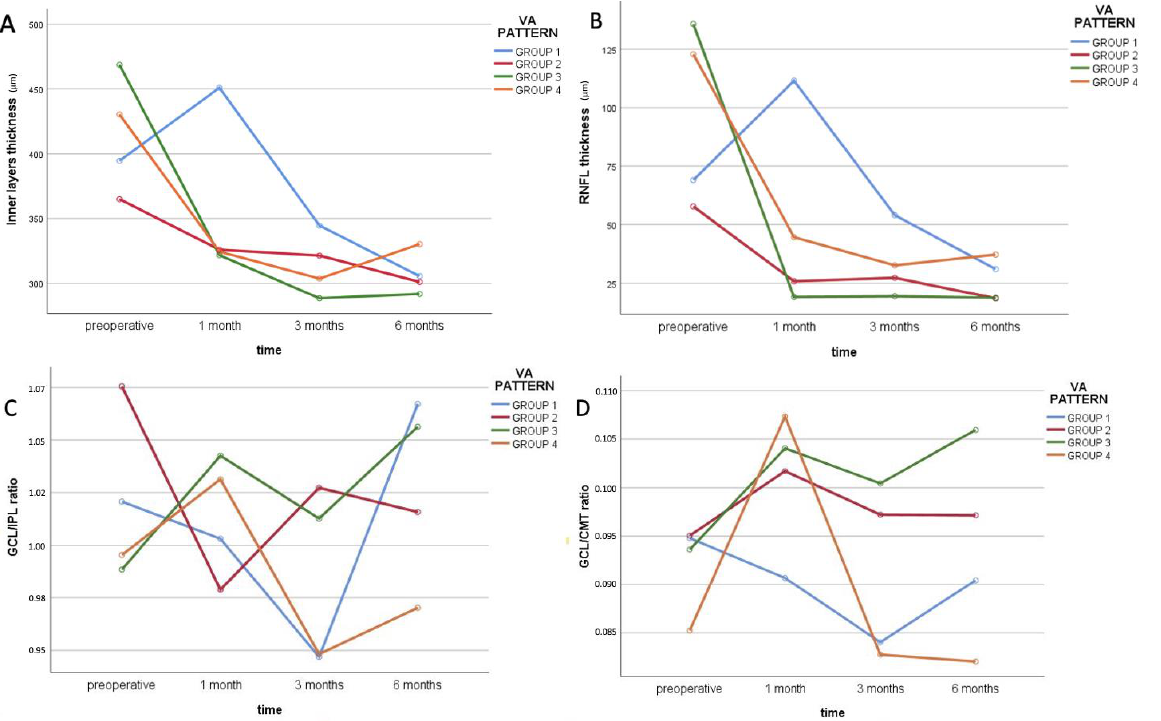
Figure 3. Visual representation of changes of inner layer thickness ( A ), RNFL thickness ( B ), GCL/IPL ratio ( C ) and GCL/CMT ( D ) over the follow-up in the 4 analyzed VA trend groups. CMT = central macular thickness; GCL = ganglion cell layer; IPL = inner plexiform layer; RNFL = retinal nerve fiber layer; VA = visual acuity.